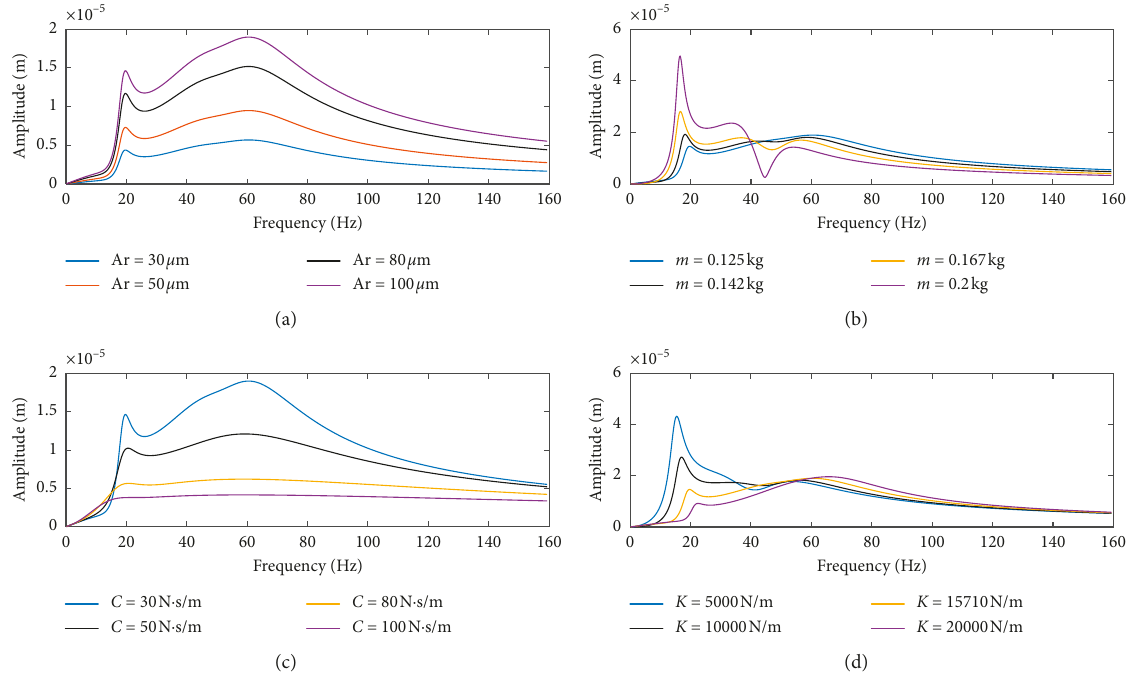
Figure 3: Analysis of influencing factors of stationary ring displacement in nonlinear operation: (a) effect of axial excitation amplitude on displacement; (b) effect of stationary ring mass on displacement; (c) effect of axial damping on displacement; (d) effect of linear stiffness on